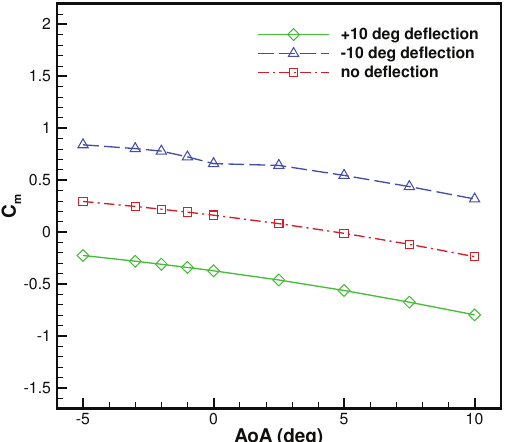
Figure 25. Elevators: pitching moment coefficient against AoA.